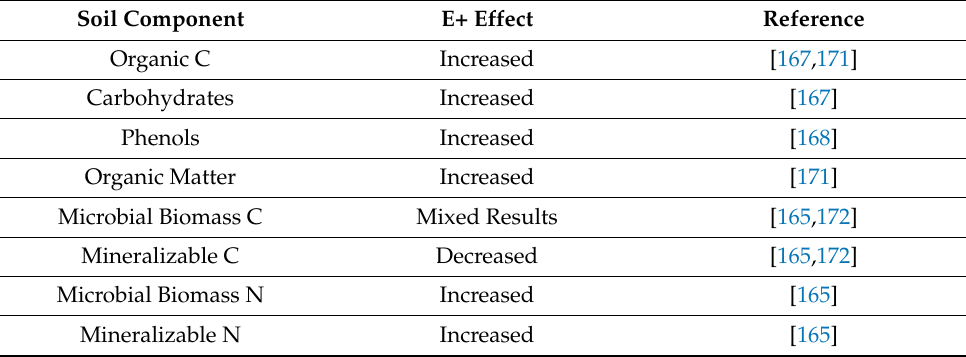
Table 2. Epichloë endophyte-infected grass influence on the accumulation of various compounds in the soil